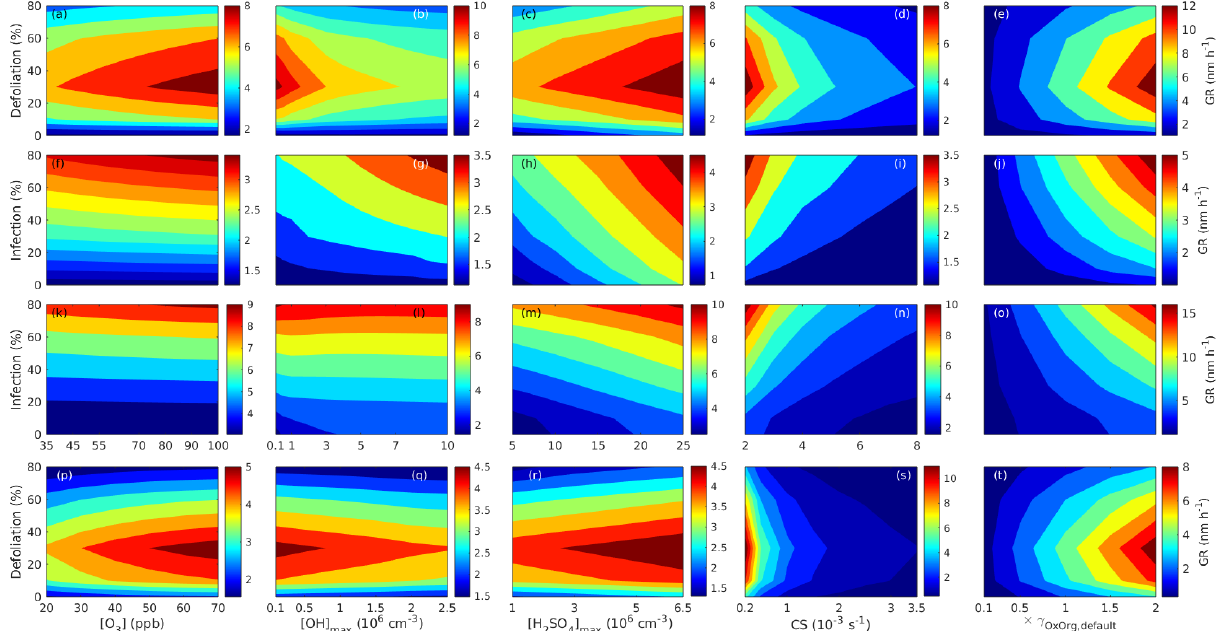
Figure D2. Impact of changed boundary conditions on the growth rate of small particles in non-infected and biotically stressed forest stands. The subplots correspond to those in Fig. 11, but the subplots here display growth rate instead of the number of particles. Thus, we refer the reader to Fig. 11 for further